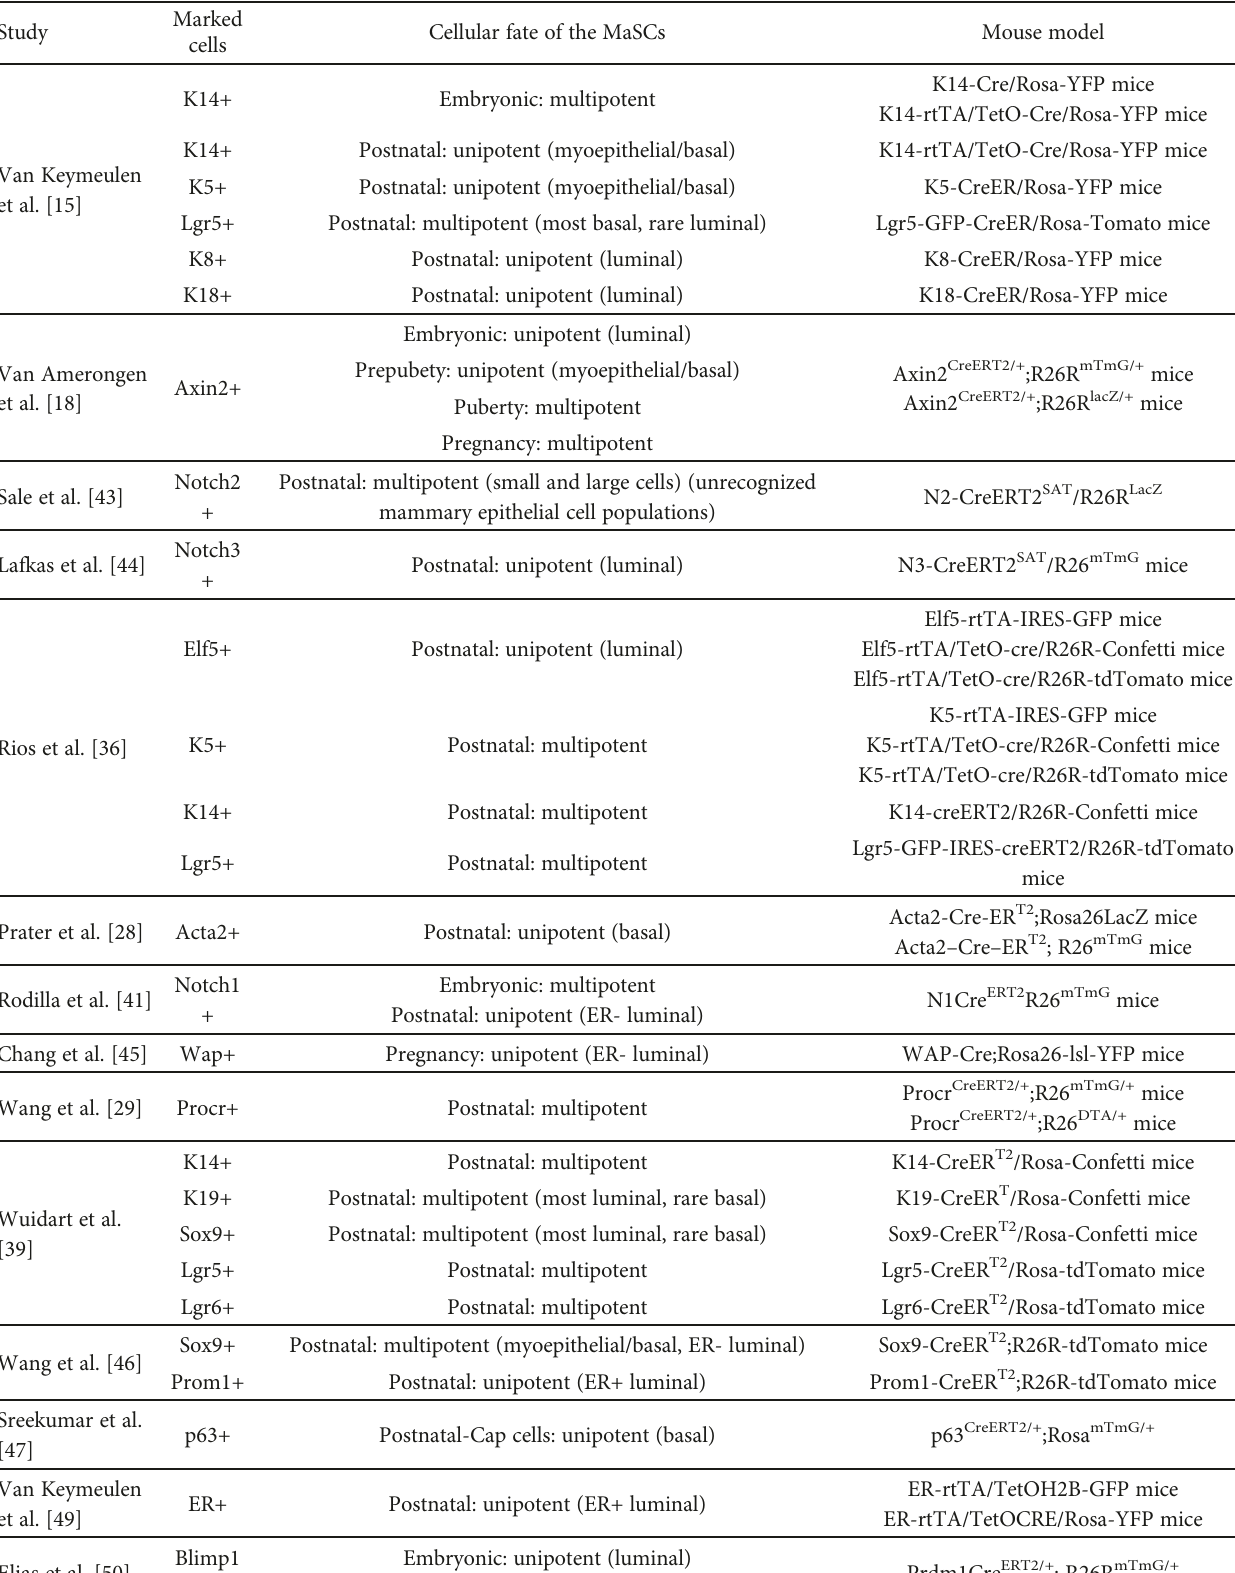
Table 2: An overview of lineage-tracing studies de fi ned MaSC markers and their cellular fate using di ff erent mouse models.